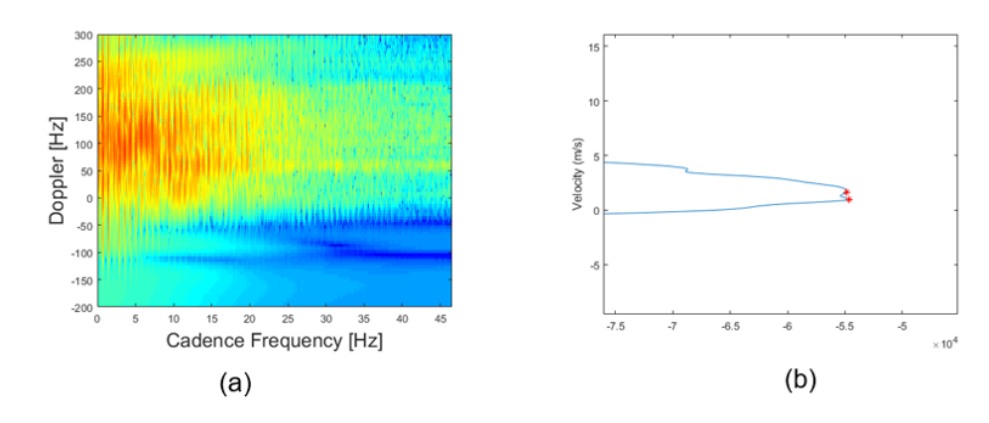
Figure 12. ( a ) CVD of walking activity from experimental data, ( b ) Horizontal projection of CVD from a noisy spectrogram.